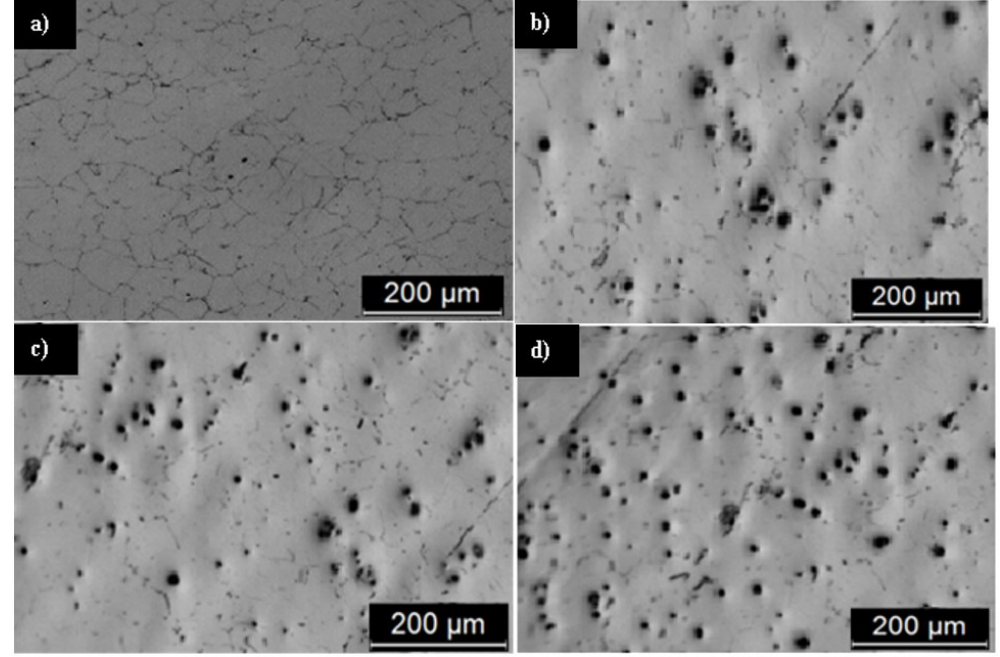
, (c) LM4 + 2 wt.% TiB 2